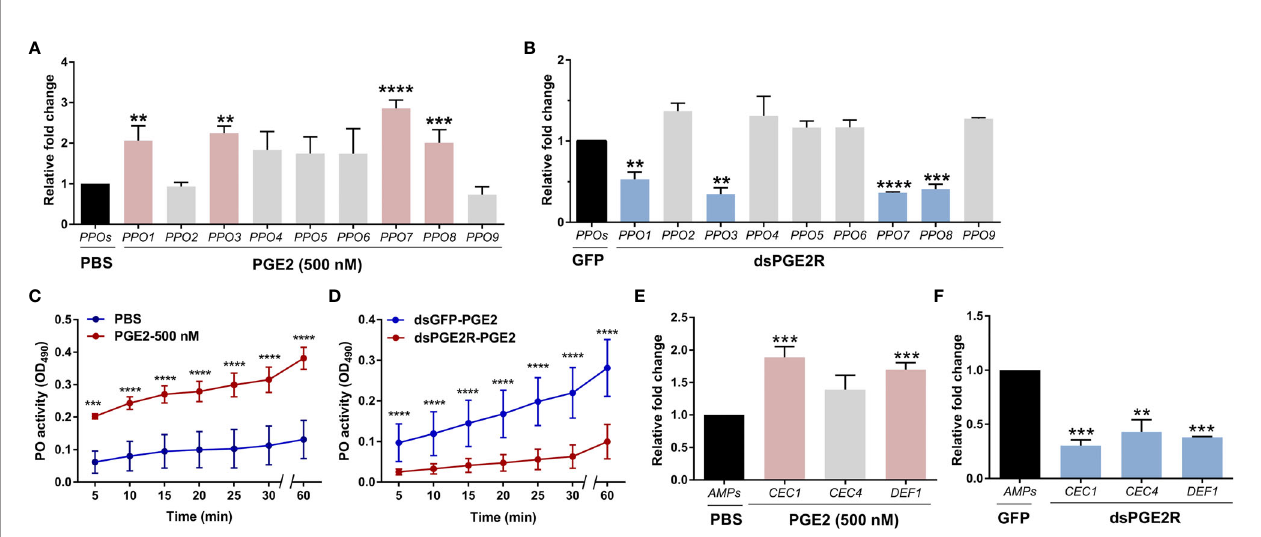
FIGURE 2 | PGE2 signaling in fl uences phenoloxidase (PO) activity and antimicrobial peptide (AMP) gene expression. Following treatment with PGE2 (500nM) (A) or when AgPGE2R was silenced (B) , the expression of all nine mosquito prophenoloxidases (PPOs) were examined by qRT-PCR and compared to respective PBS or GFP controls. For both (A, B) , mosquitoes were pooled (n=15) for analysis. Data were analyzed using an unpaired t test to determine differences in relative gene expression for each respective PPO gene between treatments. Bars represent mean ± SE of three independent biological replicates. (C) PO activity was measured from perfused hemolymph in mosquitoes primed with PGE2 (500 nM) and compared to PBS controls 24 h post-treatment (n=15 per treatment). (D) Additional experiments were performed measuring PO activity in which PGE2 (500nM) was injected into AgPGE2R - or GFP -silenced (control) mosquitoes (n=15 per treatment). For both (C, D) , measurements (OD490) were taken for DOPA conversion assays at 5-min intervals from 0 to 30 min, as well as a fi nal readout at 60 min. Data were analyzed using a two-way repeated-measures ANOVA followed by Sidak ’ s multiple comparisons using GraphPad Prism 7.0. Bars represent mean ± SE of 3 independent experiments. In addition, PGE2 priming induced expression of antimicrobial peptide (AMP) genes (E) , while AgPGE2R-silencing reduced AMP expression (F) . For (E, F) , data were analyzed using an unpaired t -test to determine differences in relative gene expression of each respective AMP gene between treatments. Bars represent mean ± SE of three independent replications. For all data, asterisks denote signi fi cance (** P < 0.01, *** P < 0.001, **** P < 0.0001). Genes that display signi fi cant differences in gene expression following PGE2 treatment are shaded in pink, while those genes differently regulated by AgPGE2R -silencing are displayed in